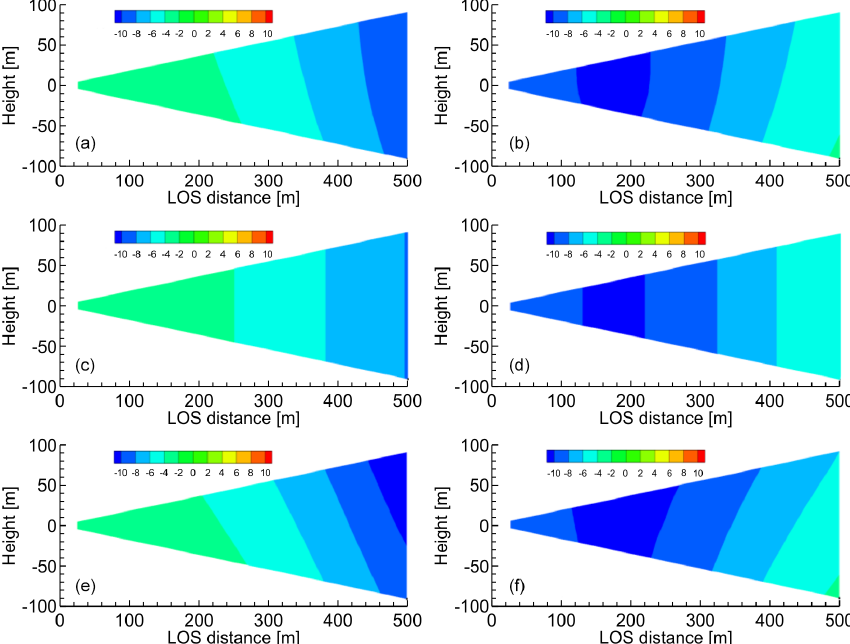
Figure 11. Distributions of the horizontal and vertical wind components estimated by the simple vector conversion method vs. the proposed method (at a time of 10s). (a, b) Ideal vortex model; (c, d) simple vector conversion method; (e, f) proposed method with five past LOS wind datasets. (a, c, e) Horizontal wind values; (b, d, f) vertical wind values.